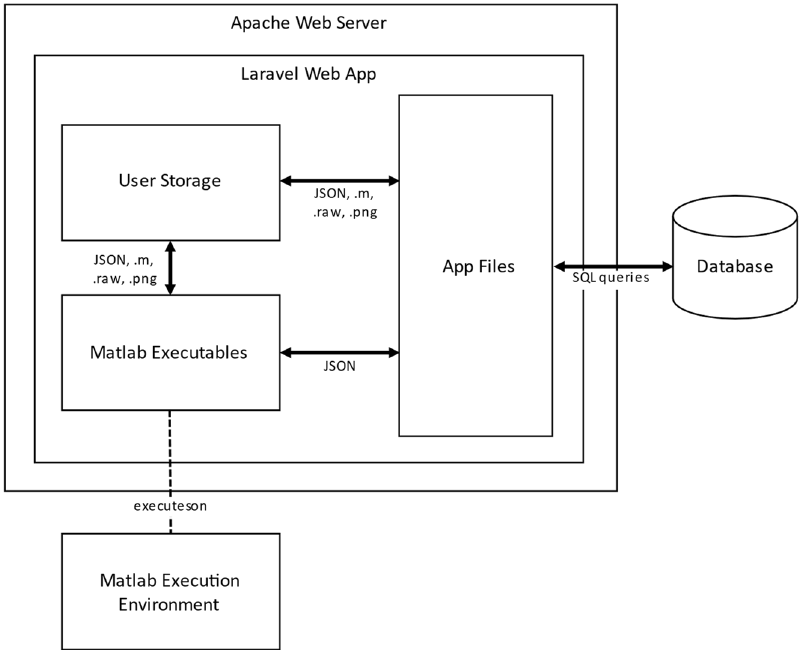
Figure 1. Software architecture and modules organization.